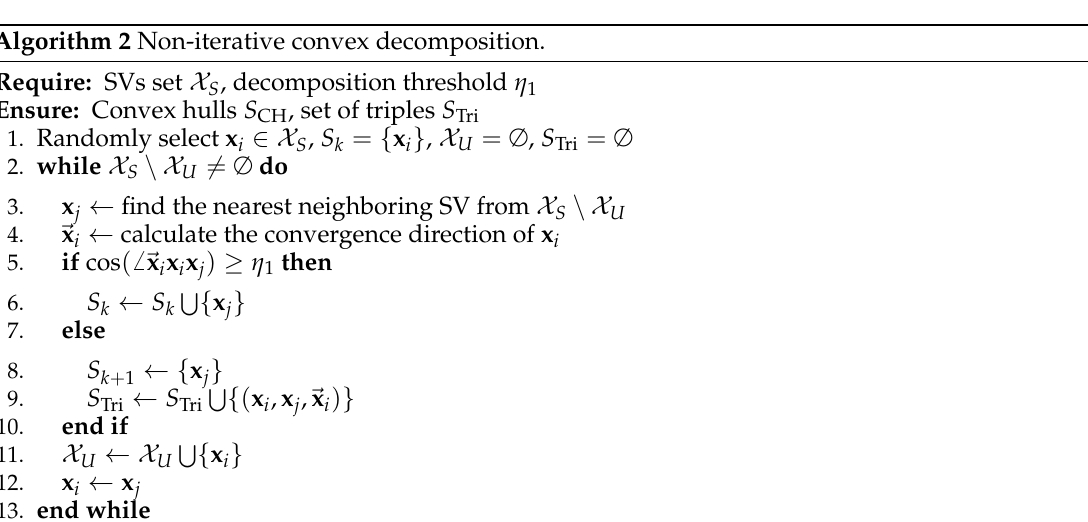
Algorithm 2 Non-iterative convex